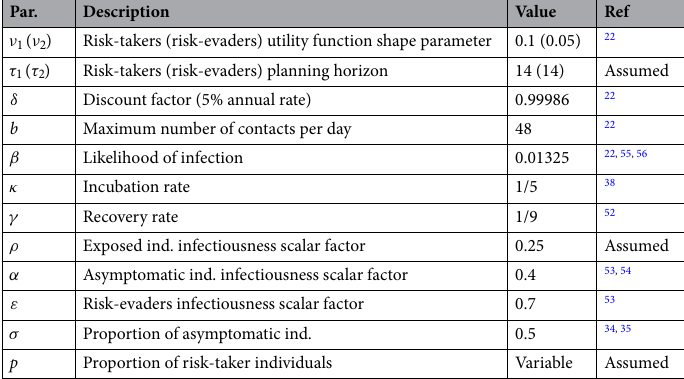
Table 1. Baseline parameters for the constant contacts and adaptive behavior model.